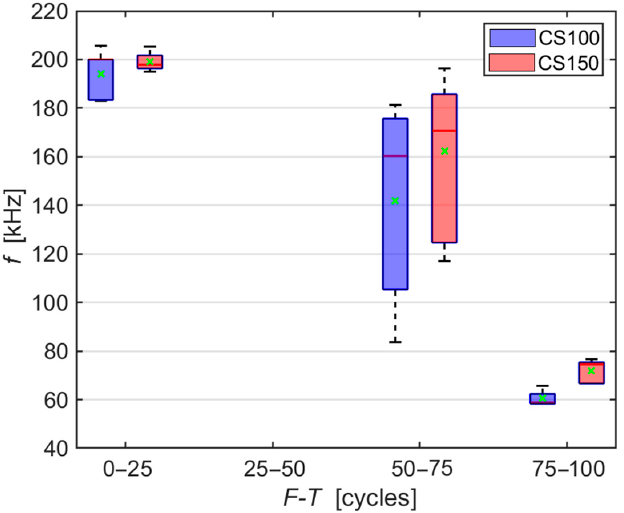
Figure 4. Box plot of development of dominant frequency values of AE hits during F-T cycles.